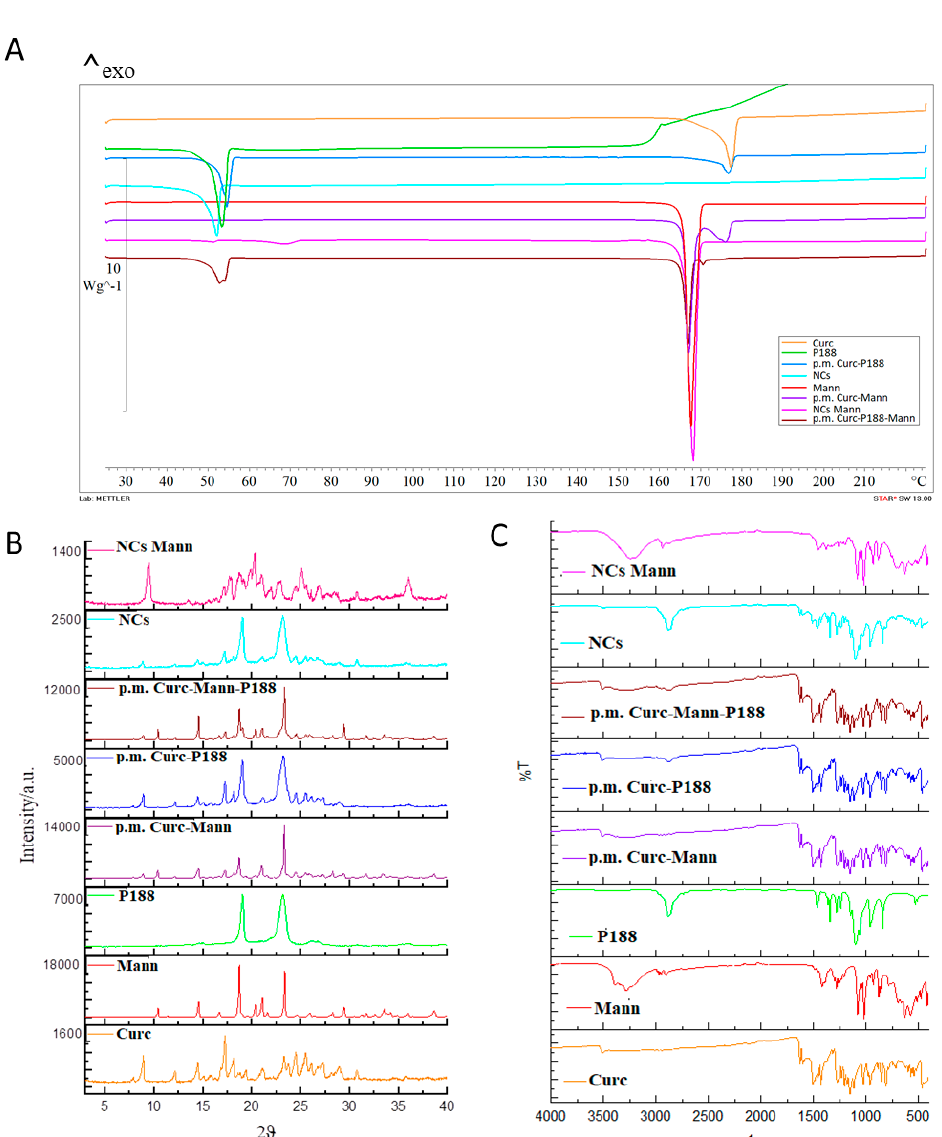
Figure 4. ( A ) Differential scanning calorimetric (DSC) thermograms of curcumin NCs with and without mannitol, curcumin (Curc), Poloxamer 188 (P188), mannitol (Mann) and the physical mixture (p.m.) of curcumin-mannitol and curcumin-poloxamer 188; and curcumin-poloxamer 188-mannitol. ( B ) XRPD spectra of the samples. Each sample was reported with the specific max intensity; ( C ) FT-IR analysis of all samples tested. Details of named samples: curcumin (Curc); mannitol (Mann); poloxamer 188 (P188); physical mix curcumin and poloxamer 188 (p.m. Curc-P188); physical mix curcumin, mannitol and poloxamer 188 (p.m. Curc-Mann-P188); physical mix curcumin and mannitol (p.m. Curc-Mann); nanocrystals (NCs); nanocrystals with mannitol (NCs Mann).